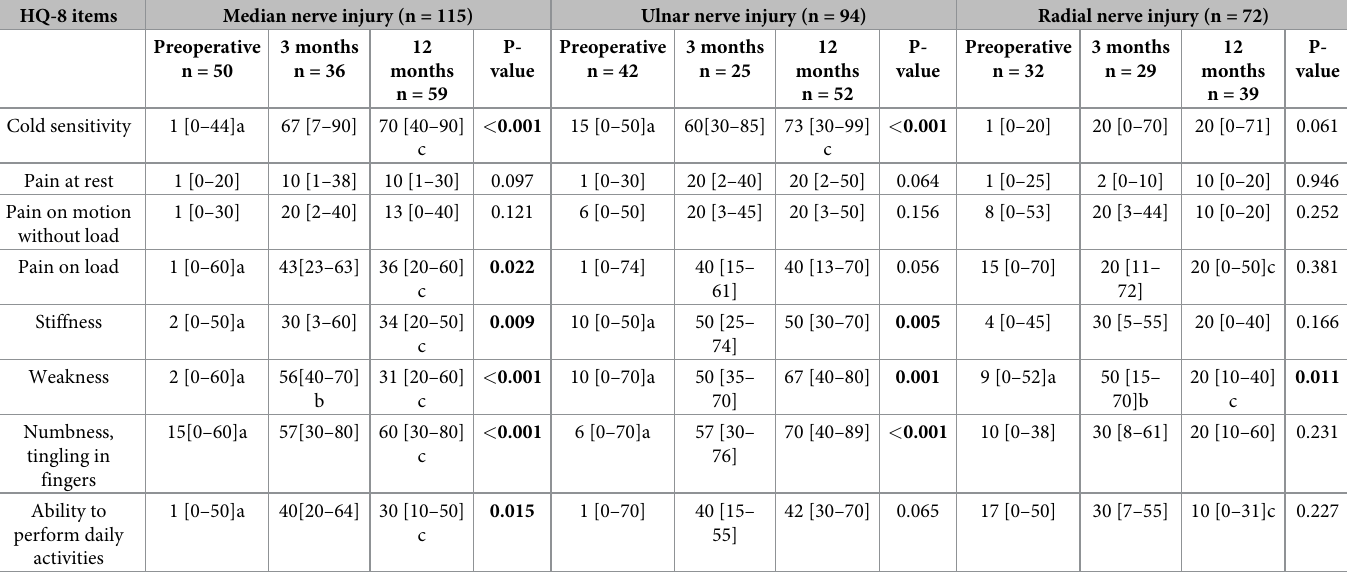
Table 2. HAKIR questionnaire (HQ-8) results in 281 individuals with a median, an ulnar or a radial nerve injury treated with sutures or nerve